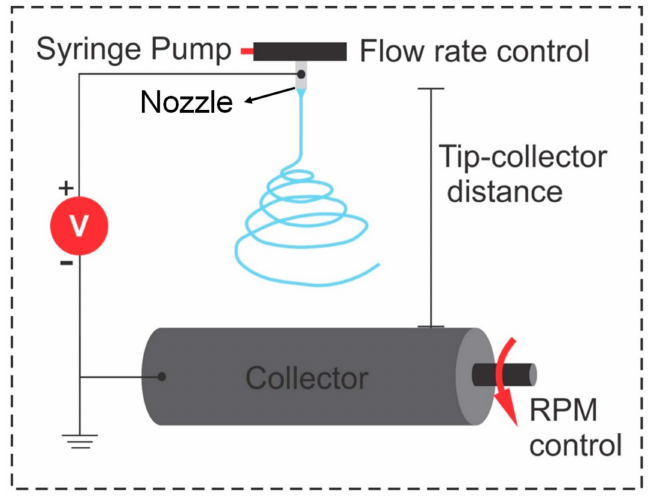
Figure 1. A basic illustration of the electrospinning set-up showing all the possible parameters that can be controlled. Adapted with permission from [18], Samerender Nagam Hanumantharao,